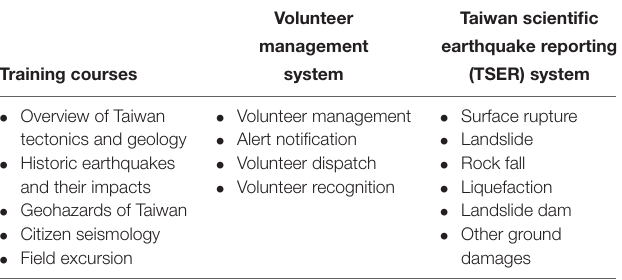
TABLE 1 | Summary of the working items for Taiwan scientific earthquake reporting system.